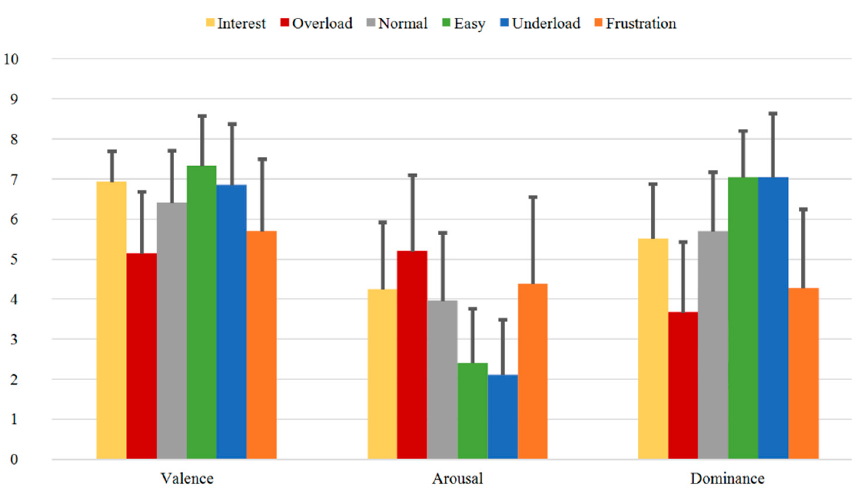
Figure 8. SAM Ratings of Group A for all sequences with mean Valence, Arousal, and Dominance.